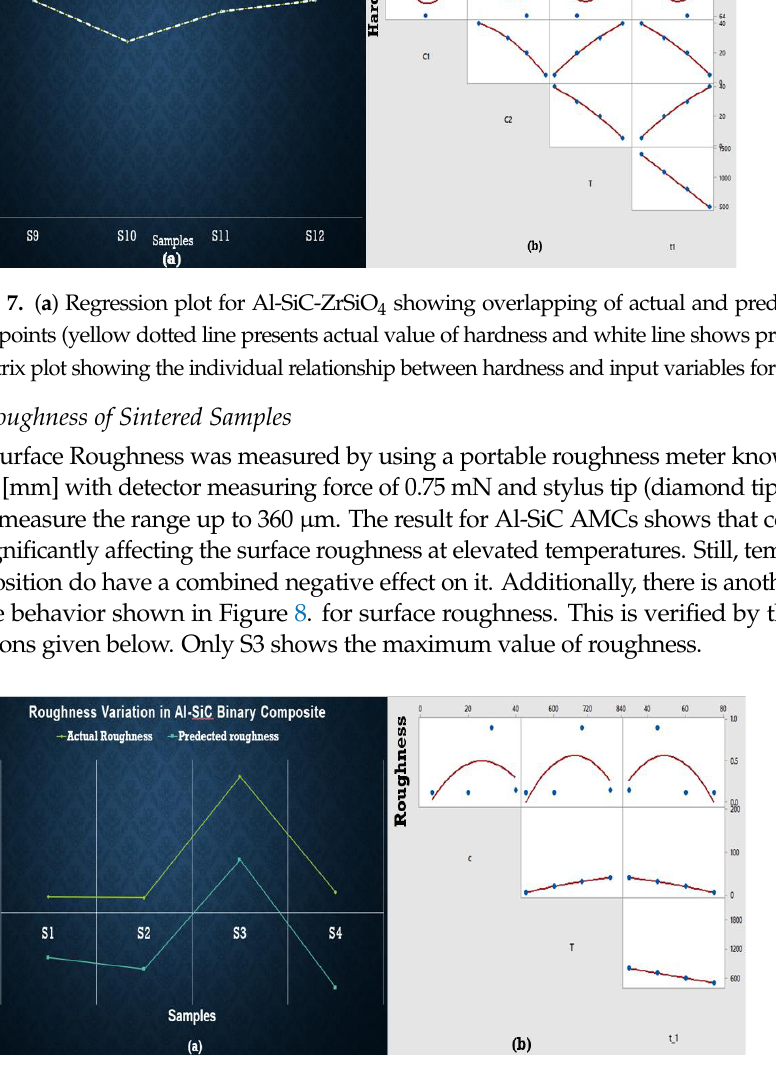
Figure 6. ( a ) Regression plot for Al-ZrSiO 4 showing overlapping of actual and predicted hardness values points (yellow dotted line presents actual value of hardness and white line shows predicted values). ( b ) Matrix plot showing the individual relationship between hardness and input variables for Al-ZrSiO 4 .